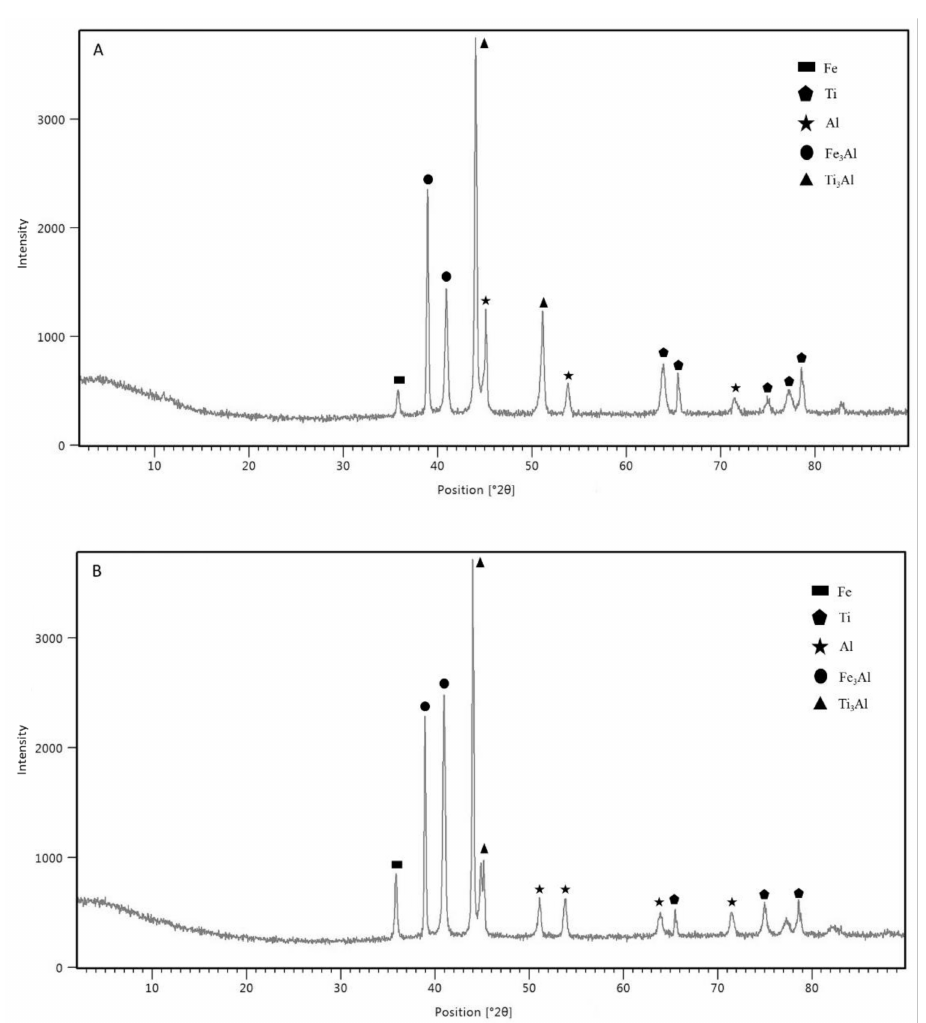
Figure 16. XRD result along the SS–Al–Ti joint cross-sectional cut: ( A ) sample 1; ( B ) sample 3. Meanwhile, the microhardness value of the titanium side’s base metal was measured at 254.2 HV for sample 1 and 279.5 HV for sample 3. The heat-affected zone which had the dominant β phase due to the less generated heat input produced the microhardness value of 281.2 HV for sample 1 and 300.4 HV for sample 3. The highest microhardness value was also located at the fusion zone of the titanium side which had the microstructure formation of α ’ martensite phase due to the massive heat input and rapid cooling rate. The phase transformation of titanium causes the microhardness value to increase significantly. The highest microhardness value was recorded at 334 HV for sample 1 and 347.5 HV for sample 3. Conclusively, the comparison between low heat input and high heat input which was implemented on sample 1 and sample 3 delivered a significant difference on the microhardness value. Higher heat input causes a higher microhardness value due to the significant phase transformation of each